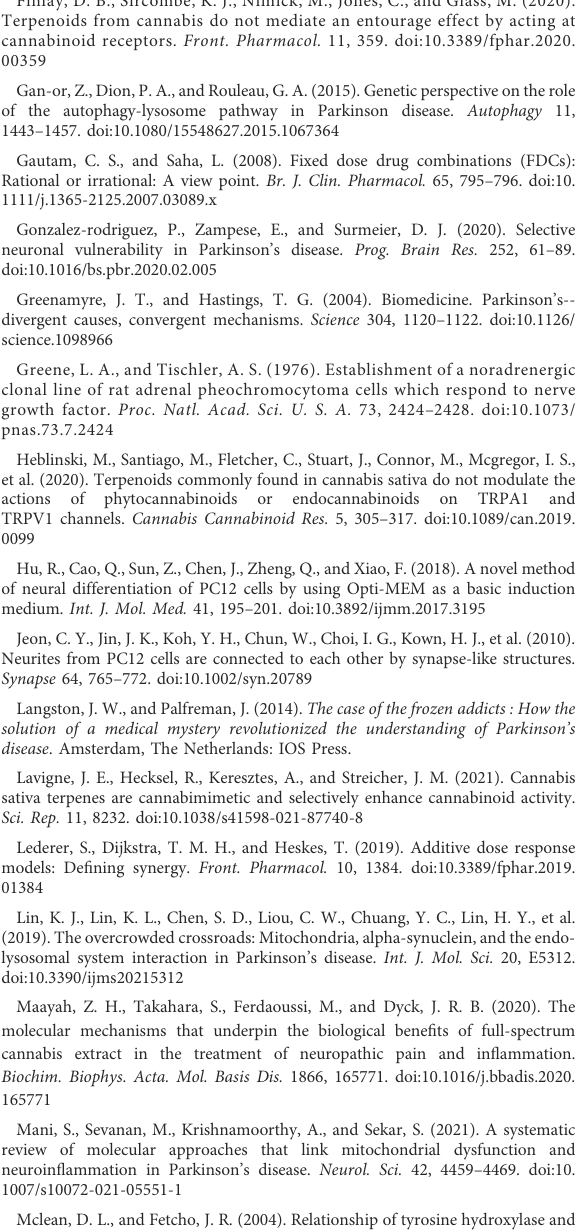
SUPPLEMENTARY FIGURE S1 Preliminary dilution range testing of cannabinoids in MPTP/MPP + protection assay. The percent protection from MPTP/MPP + induced cytotoxicity was initially measured at 5 concentrations to establish an effective dose range. * = p < 0.05. See manuscript for methods.